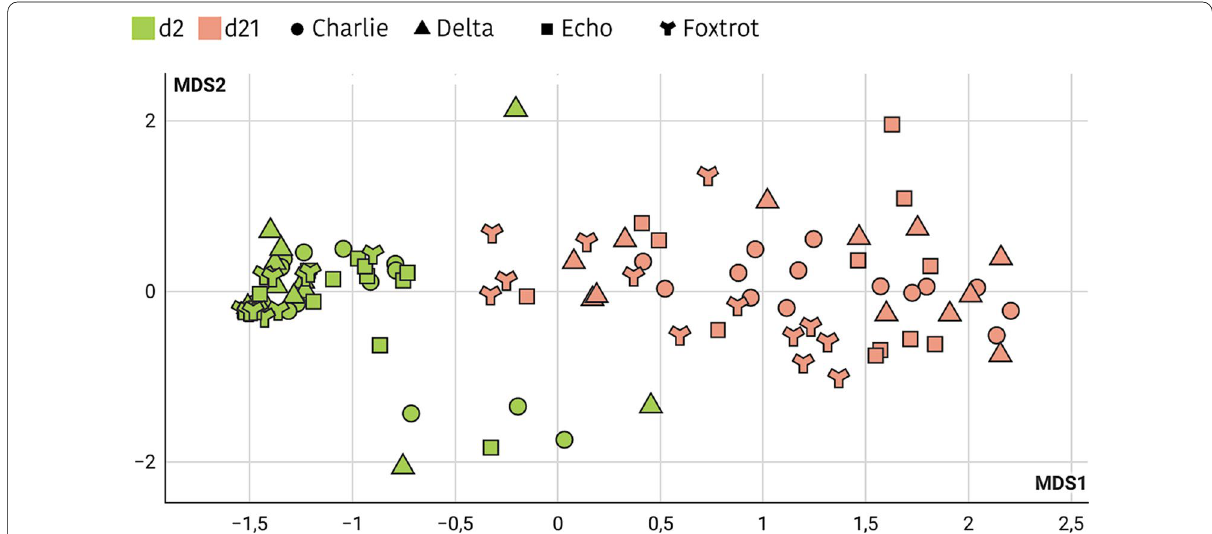
Fig. 4 NMDS of the relative abundances of ASV in Trial 2. Different colours have been used to highlight each sampling day and different shapes to distinguish each farm. A significant impact shaping the gut communities is produced by the piglets’ age ( p < 0.001) with two clear clusters between 2‑day‑old piglets and 21‑day‑old piglets. A greater richness was observed in 21‑day‑old piglets when compared to 2‑day‑old piglets ( p < 0.001). Farm and medicated feed were not found to be significant by the NMDS